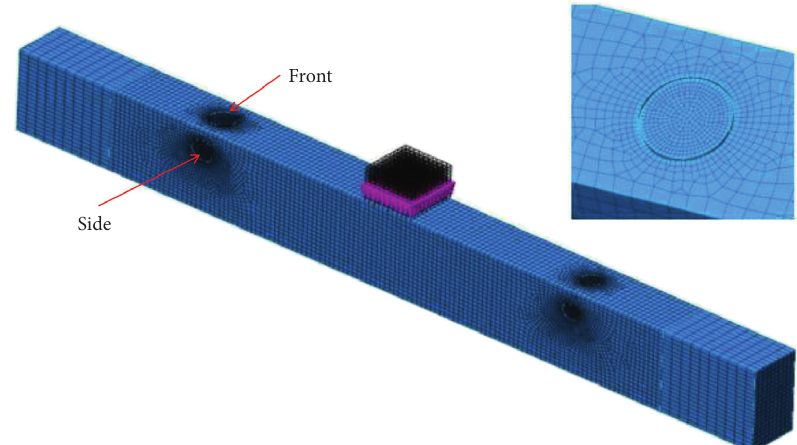
Figure 3: Drill hole position, meshing, and loading diagram.